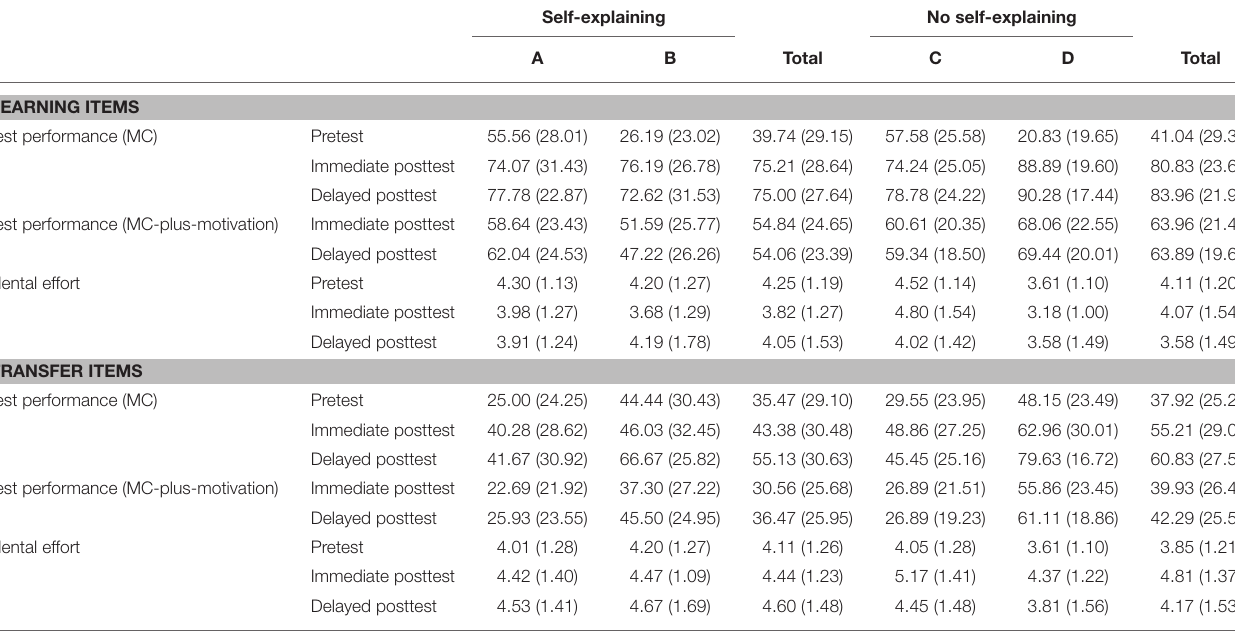
TABLE 2 | Means (SD) of Test performance (multiple-choice % score), Test performance (multiple-choice plus motivation % score), and Mental effort (1–9) per Condition and